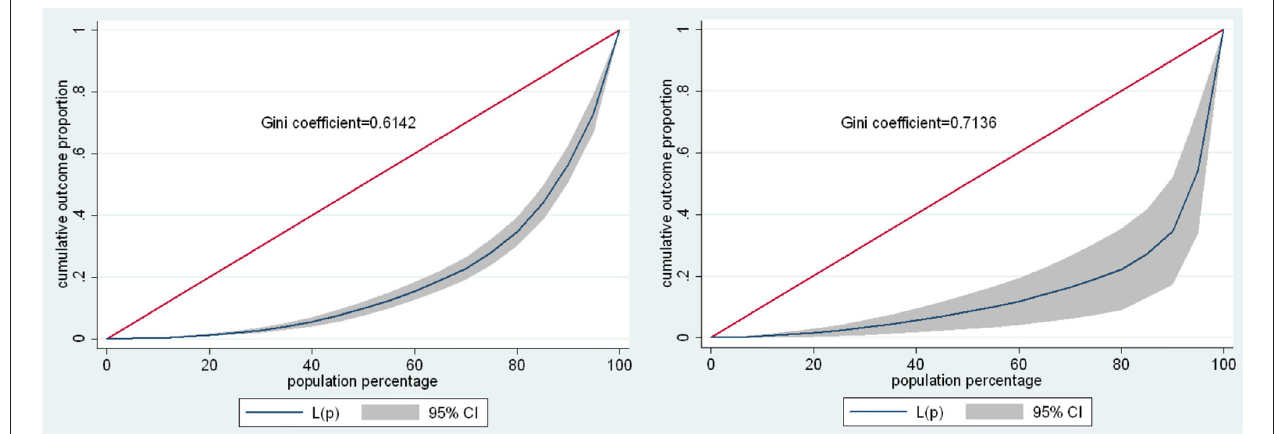
FIGURE 4 | GINI coefficient of the self-employed—2019 and 2020. Source: Own elaboration with information from ENAHO-INEI-2019 and 2020. Where: G: Gini Coefficient; X: Cumulative proportion of the population variable; Y: Cumulative proportion of the income variable.